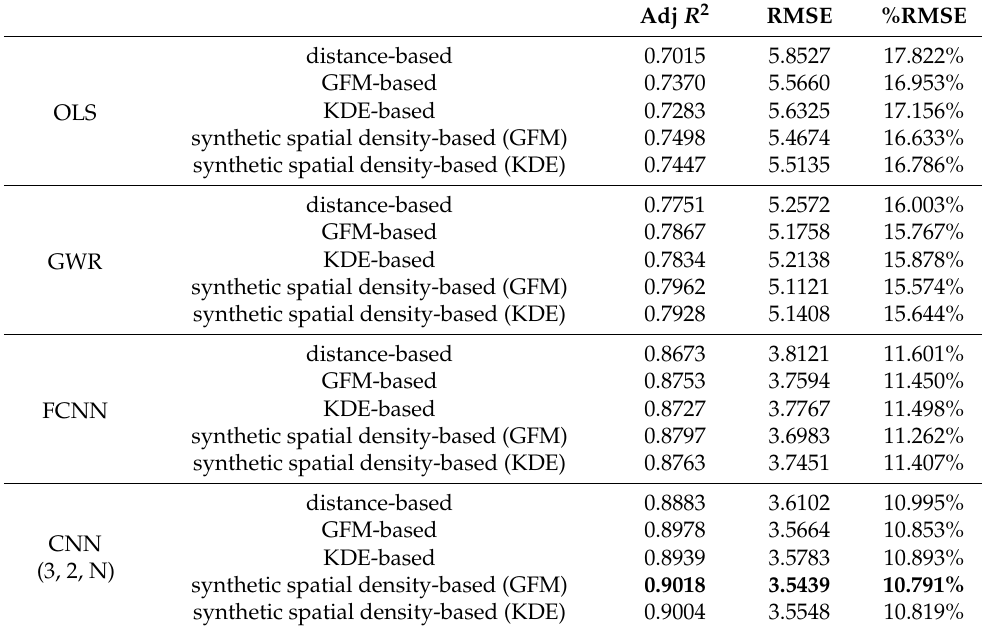
Table 4. Results of different kinds of locational and neighborhood